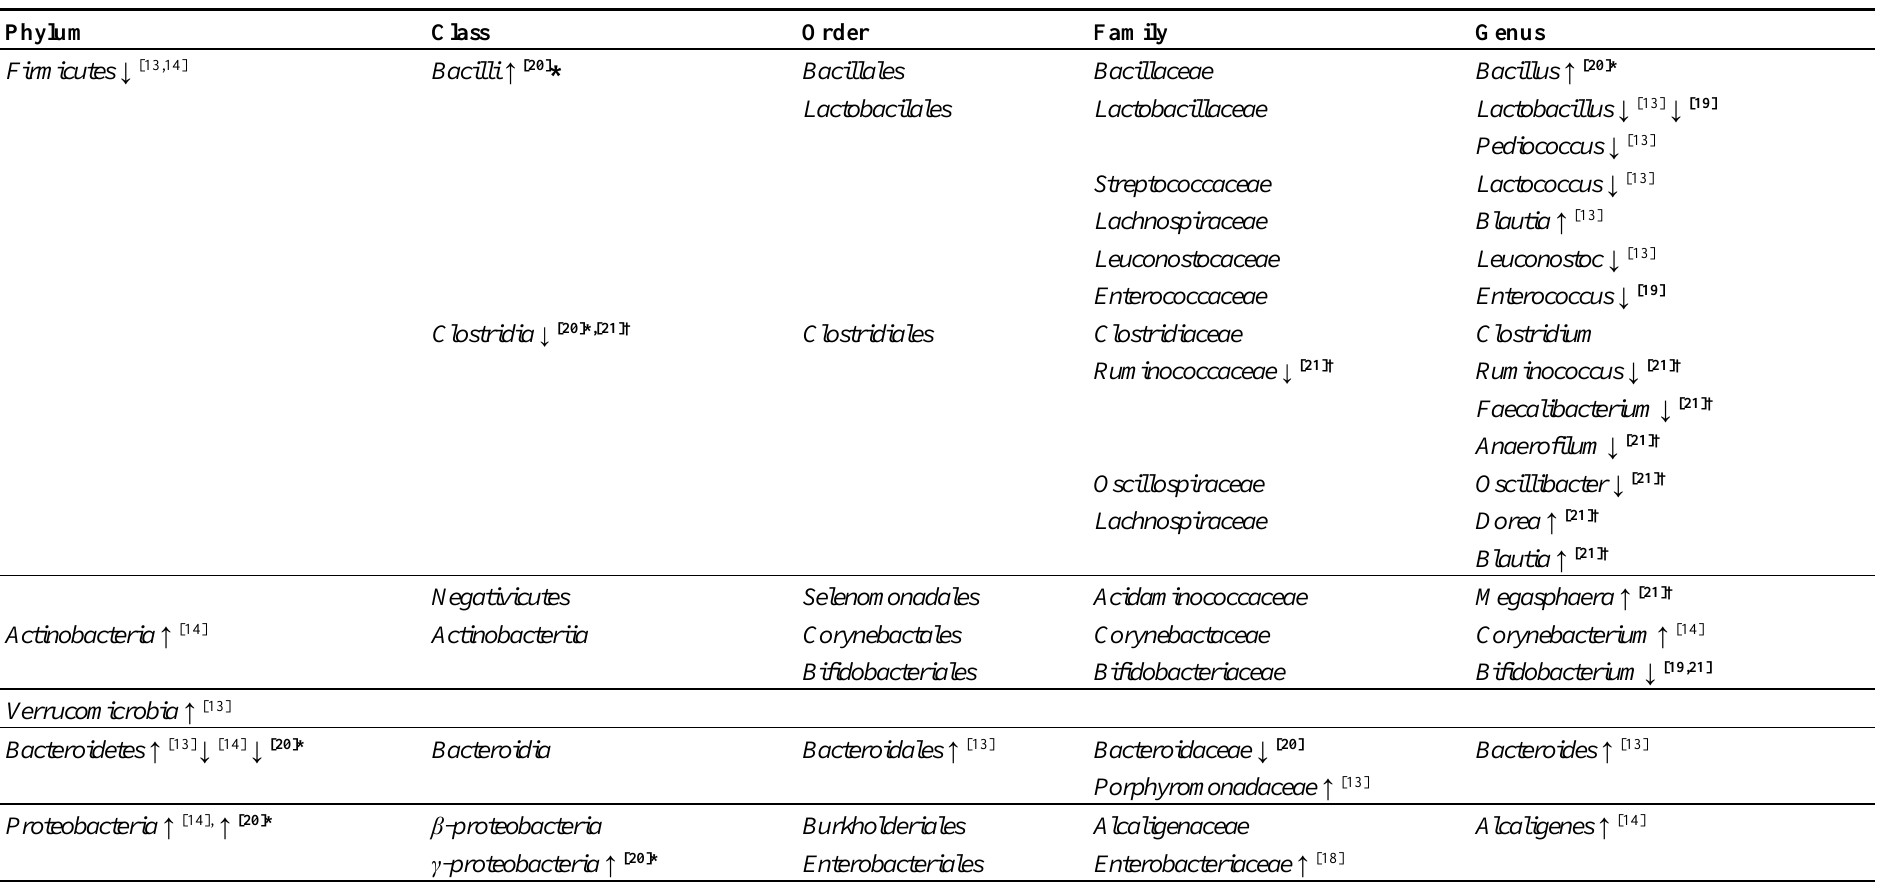
Table 1. Changes in intestinal microbiota associated with experimental and clinical studies on alcoholic liver disease